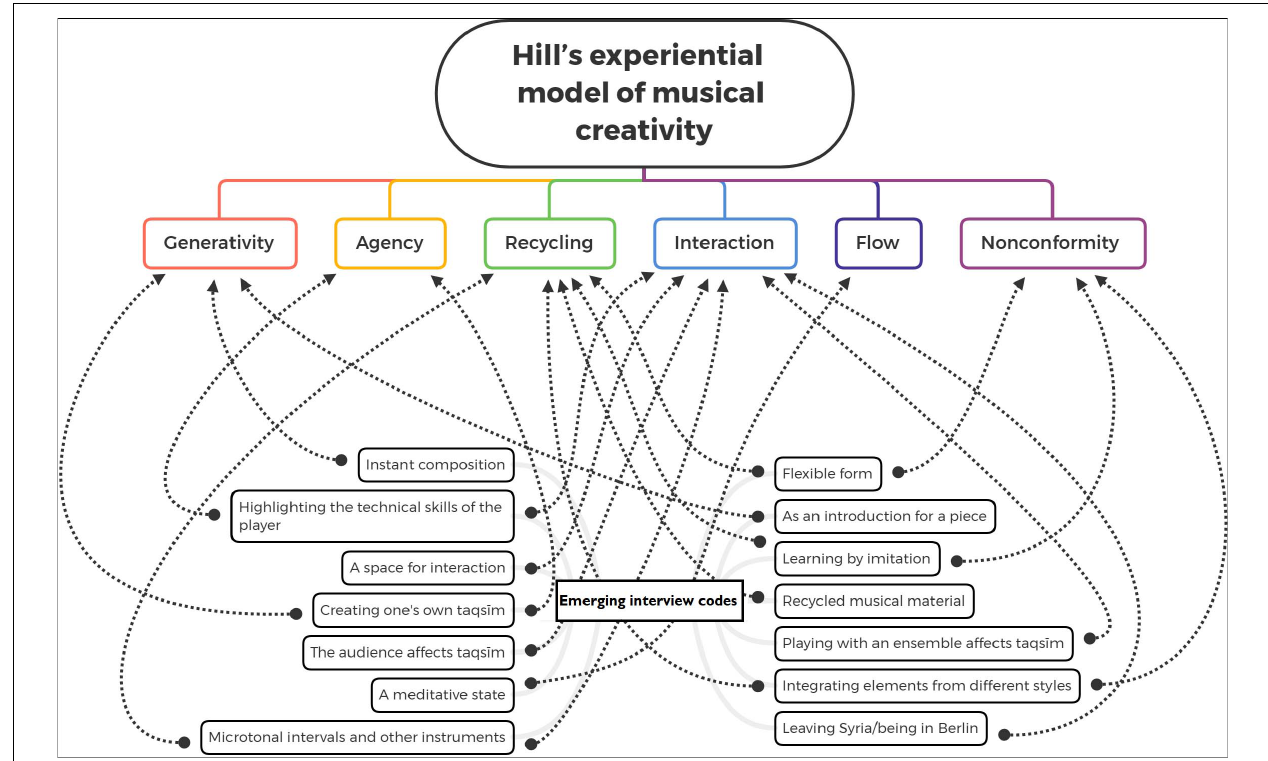
FIGURE 1 | Mapping between the interview codes and Hill’s model components of musical creativity (generativity, agency, interaction, non-conformity, recycling, and flow). All components of Hill’s model were evident in our analysis of the particpants’ answers on